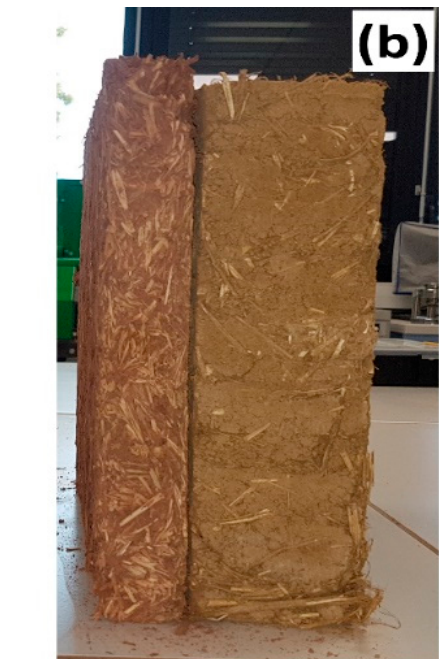
Table 11. Physical Properties of the Thermal Insulating Materials Based on GWM-FA-CR and 25% Reed Fiber after 28 Days of Curing Compared to Those of Standard Cob Insulating Building Materials from the